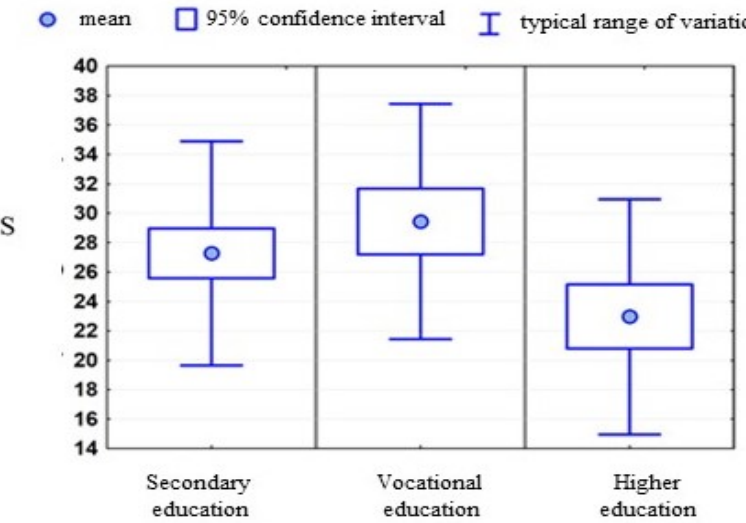
Figure 2. Correlations between the psychometric scales used and the level of education. Mean value +/ − standard deviation.